Question: Write a caption explaining this figure to a reader.
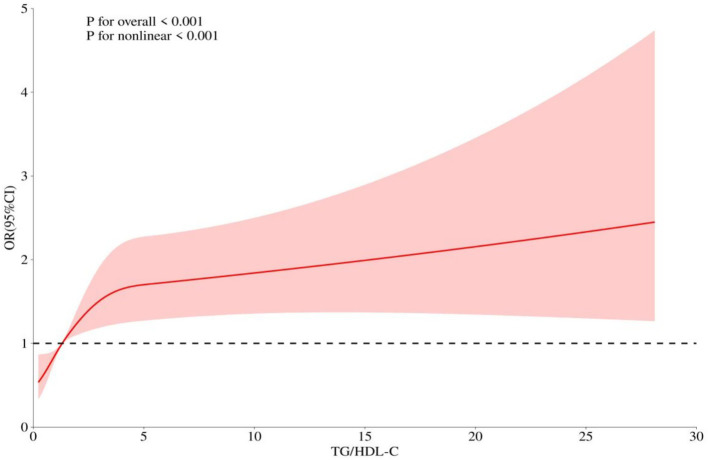
Answer: Restricted cubic spline (RCS) analysis of the relationships between TG/HDL-C and albuminuria. The solid line represents the OR, with the shaded area representing the 95% CI. Adjustments were made to the model for age, gender, smoking status, drinking status, hyperlipidemia, hypertension, e-GFR, BMI, HbAlc and HOMA-IR.